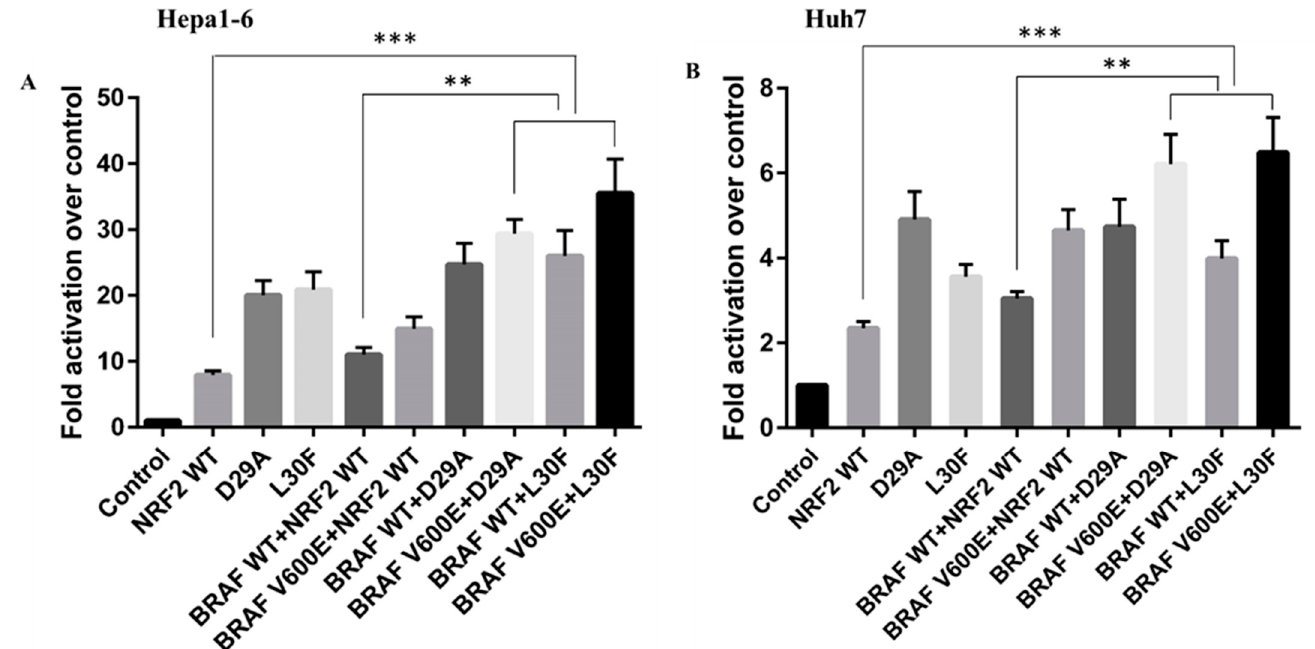
Figure 5. ( A ) The ability of NRF2 WT and MT expression plasmids together with oncogenic BRAF WT and V600E MT expression plasmids to transactivate a NRF2 target promoter (3xARE) in Hepa1-6 cells. ( B ) The ability of the NRF2 WT and MT expression plasmids together with oncogenic BRAF WT and V600E MT expression plasmids to transactivate the MMP9 promoter when overexpressed in Huh7 cells. Data represent the mean ± SEM of 4 independent experiments (**, p < 0.01; ***, p < 0.001).